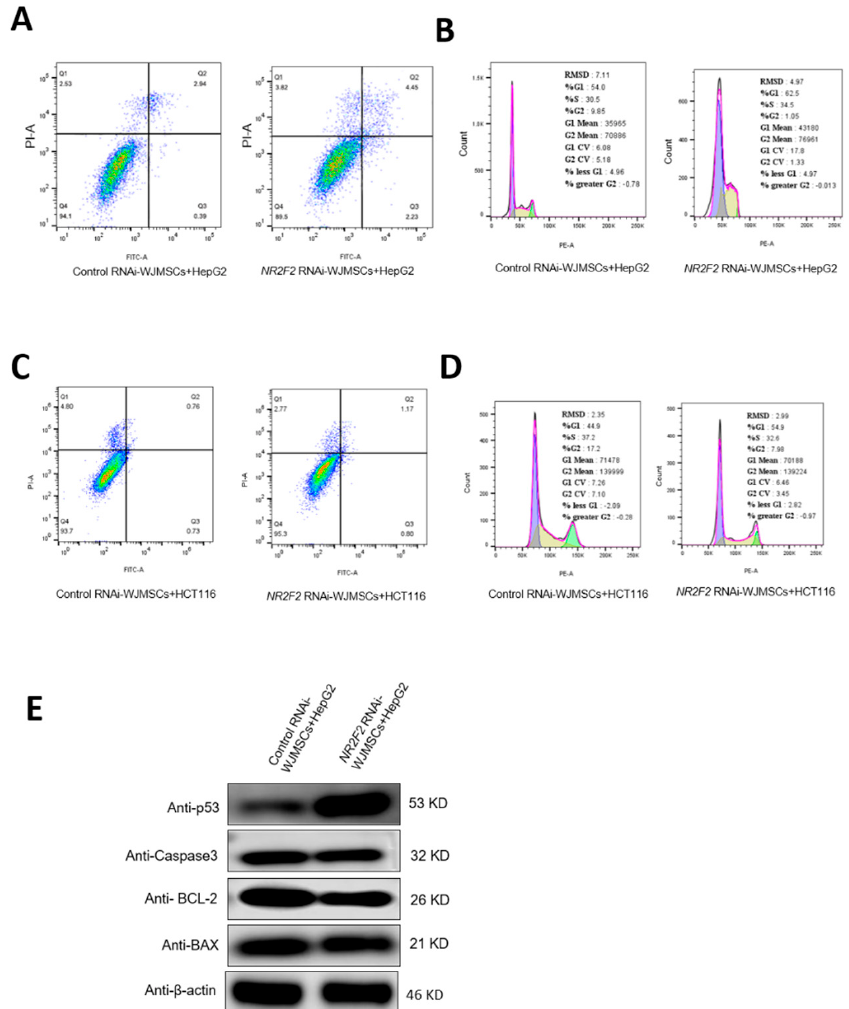
Figure 6. NR2F2-depleted WJ-MSCs regulate the growth of HepG2 and HCT116 cells in different ways. ( A ) Apoptosis of HepG2 cells. ( B ) HepG2 cell cycle changes. ( C ) Apoptosis of HCT116 cells. ( D ) HCT116 cell cycle changes. ( E ) Western blot analysis of apoptosis-related protein expression.